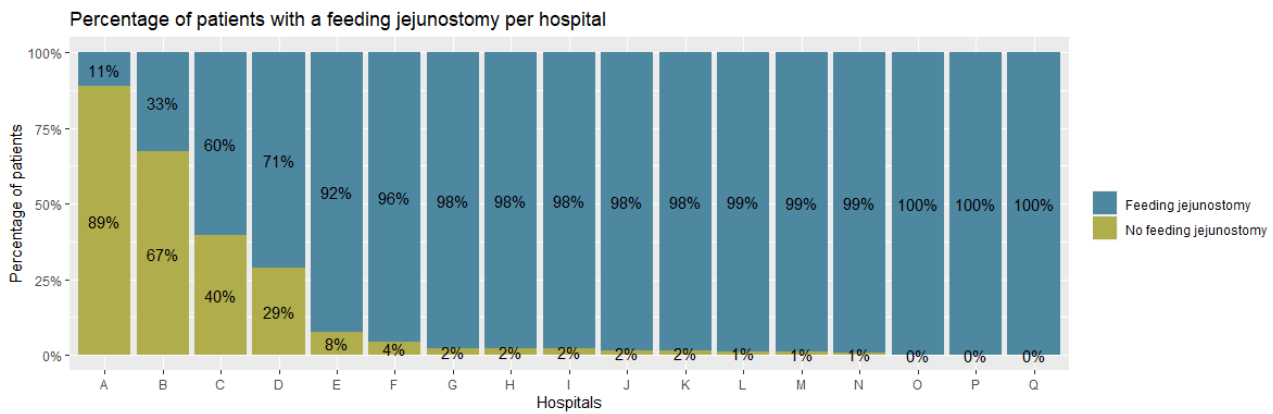
Figure 2. Bar chart showing hospital variation in the placement of feeding jejunostomies, by